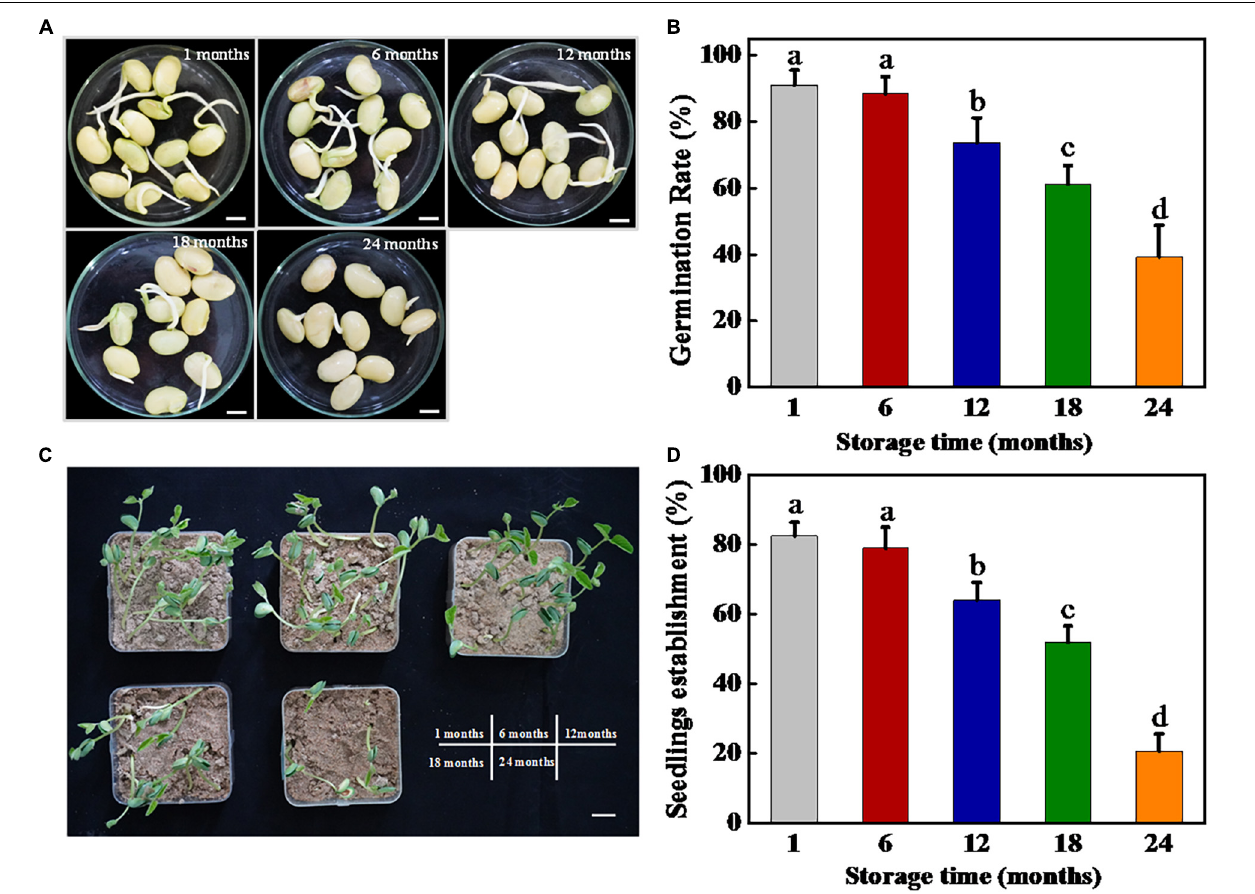
FIGURE 1 | Storage significantly inhibited soybean seed germination and seedling establishment. (A) Images of soybean seeds at 3 days of germination. Scale bar, 10 mm. (B) Germination rates of soybean seeds at 5 days of germination. (C) Images of seedling emergence from soybean seeds at 5 days postsowing. Scale bar, 600 mm. (D) Seedling emergence rates of soybean seeds at 5 days postsowing. Different lowercase letters indicate significant differences between different treatments ( p < 0.05).